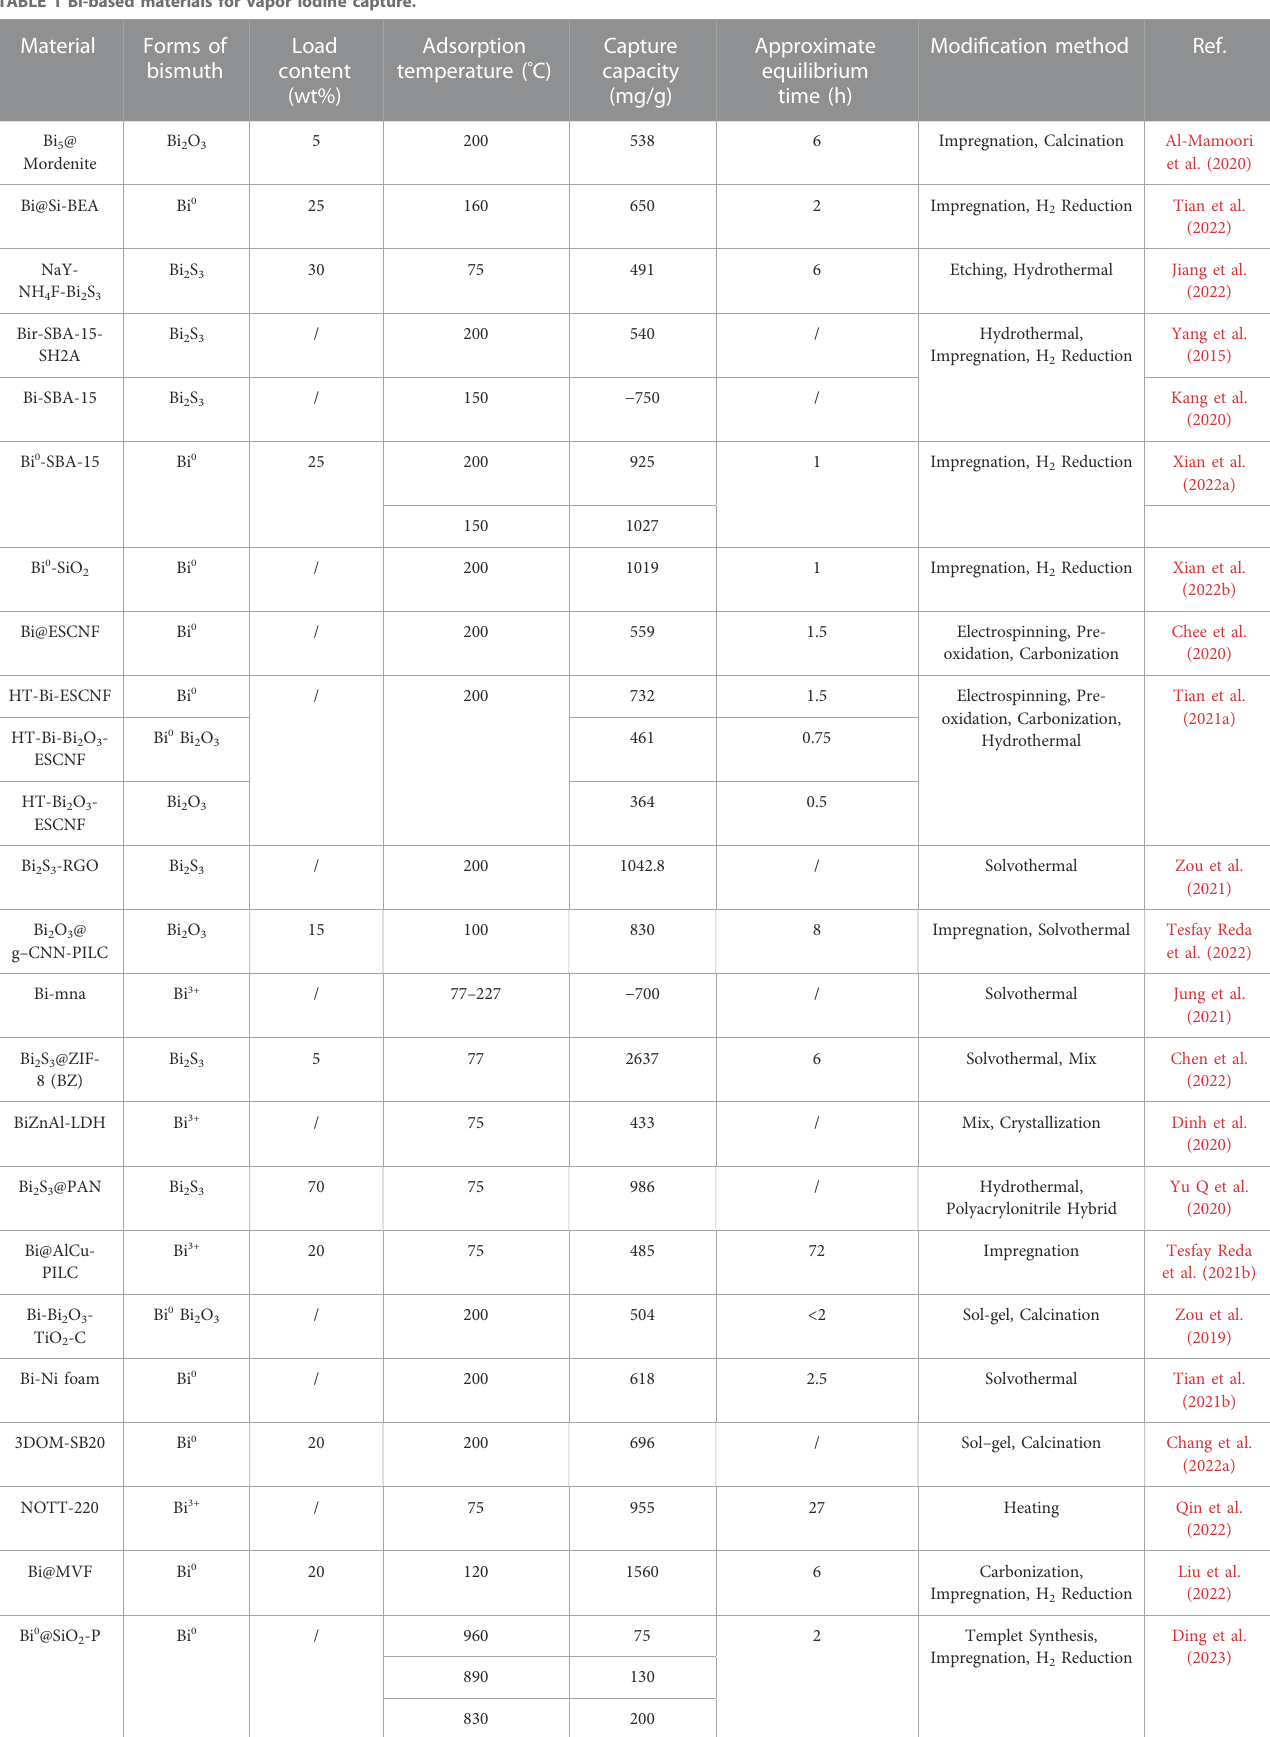
TABLE 1 Bi-based materials for vapor iodine